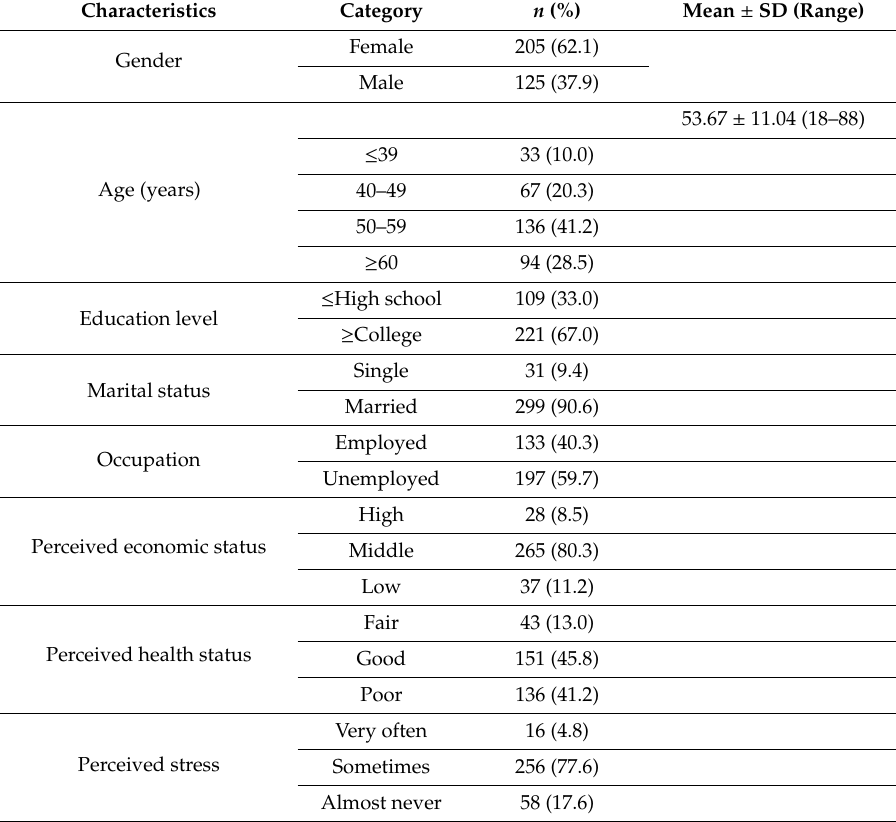
Table 1. Characteristics of the family members, N =